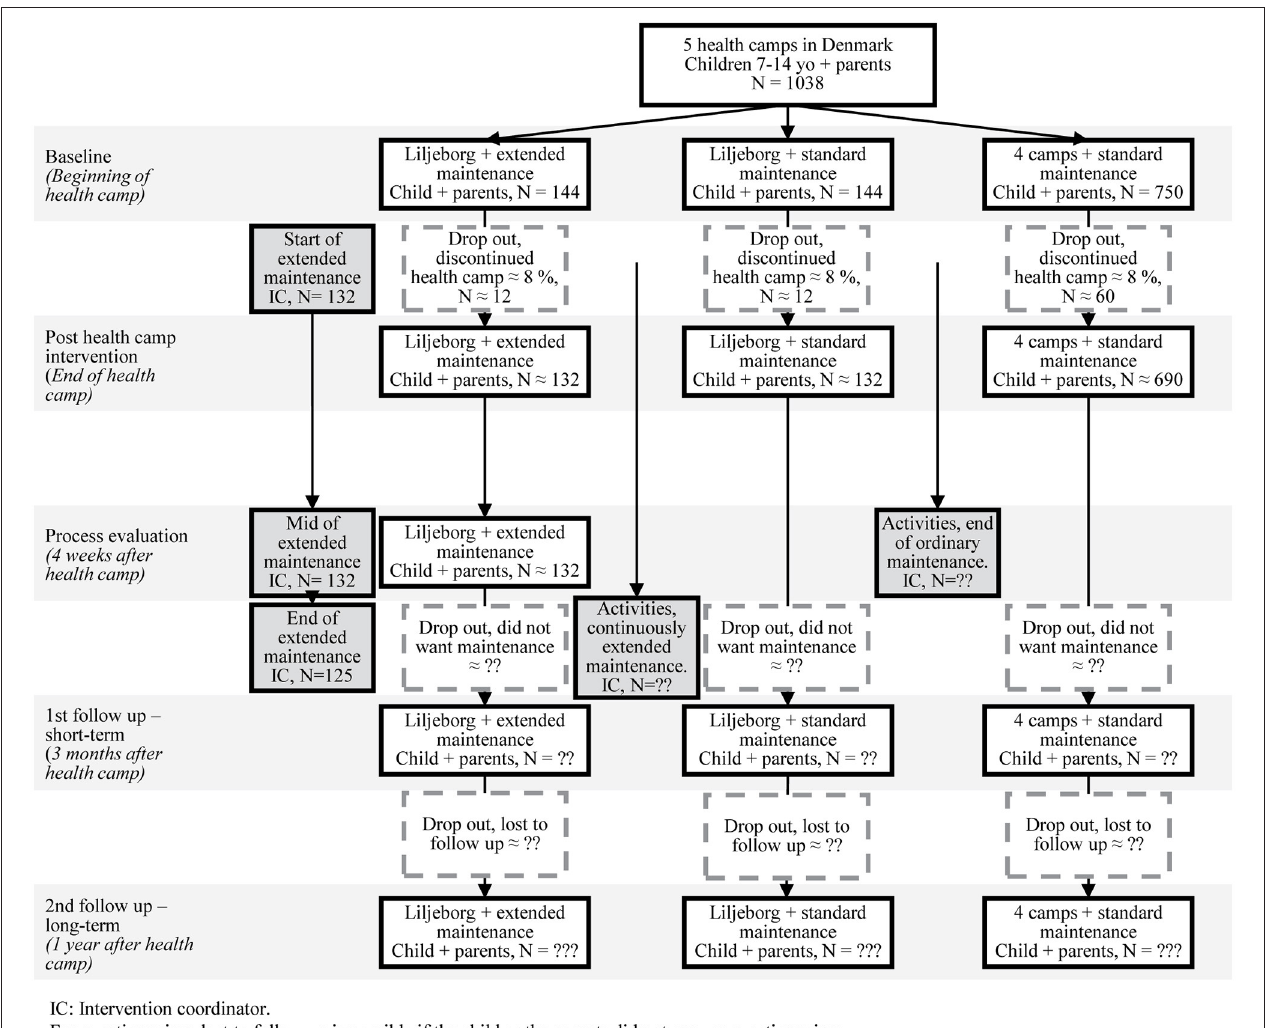
FIGURE 4 | Flowchart of expected numbers of